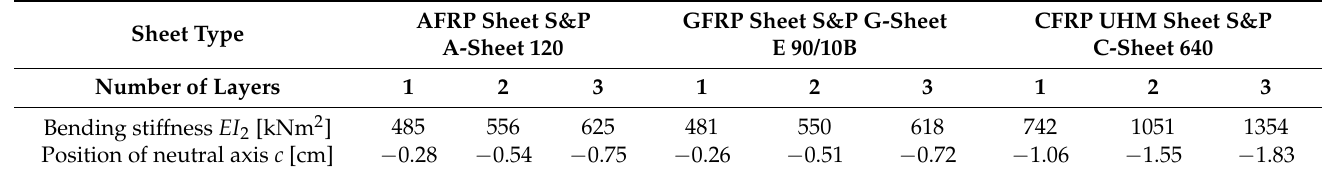
Table 4. Predicted values of bending stiffness and position of neutral axis for reinforced LVL